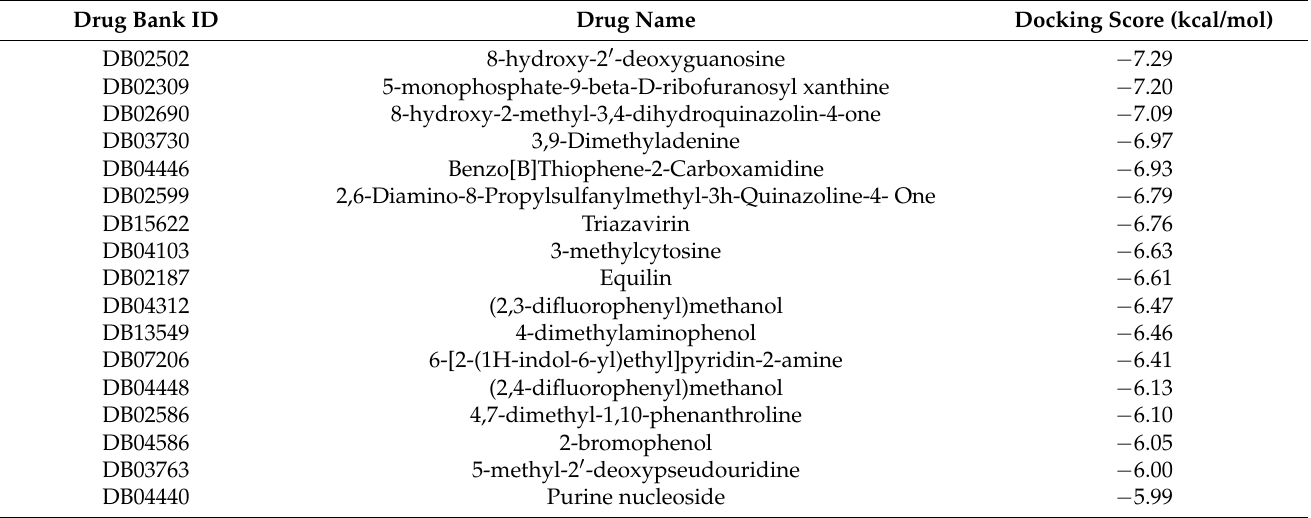
Table 3. Docking score of experimental